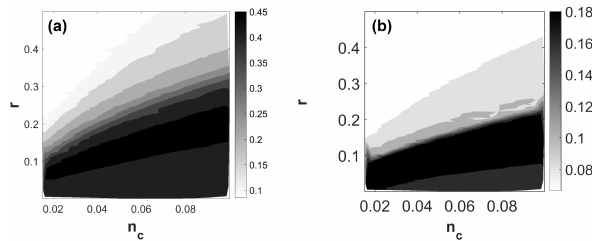
Figure 4. Single SAR acquisitions are compared with LISFLOOD- FP modelled flood maps. (a) Results from the SAR acquisition on 23 July 2007 at 10:27GMT, (b) results from the SAR acquisition 24 January 2008 at